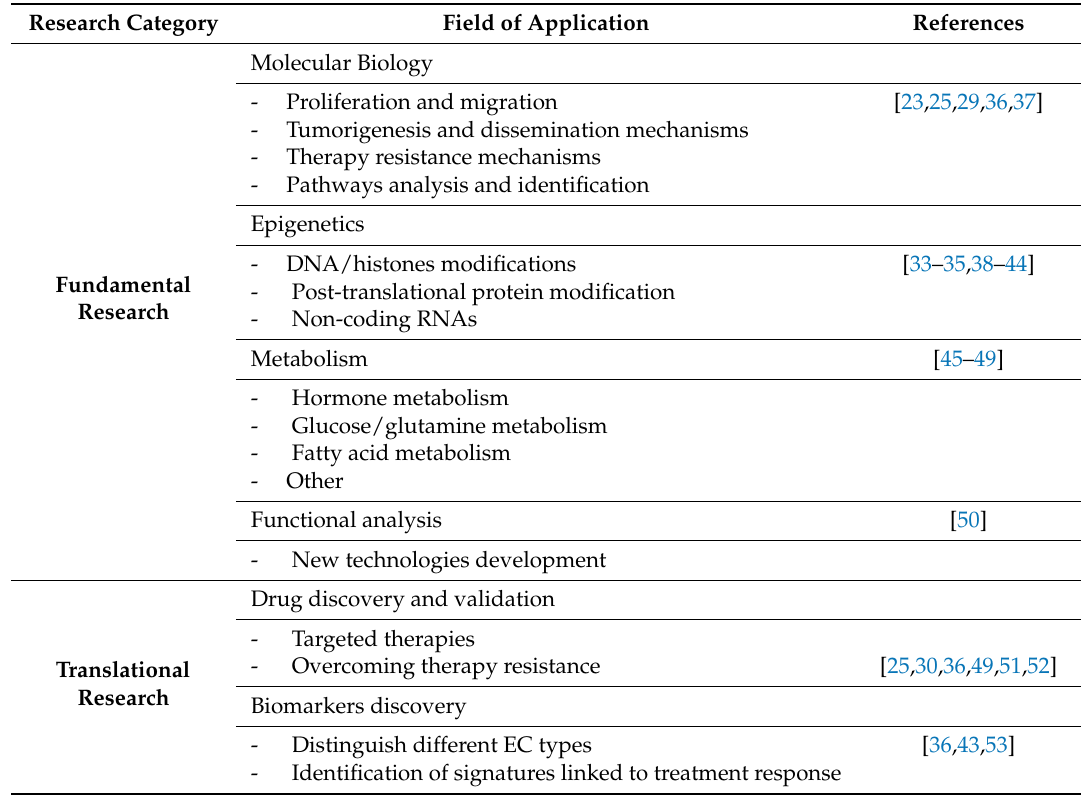
Table 2. Potential applications of EC cell lines for preclinical